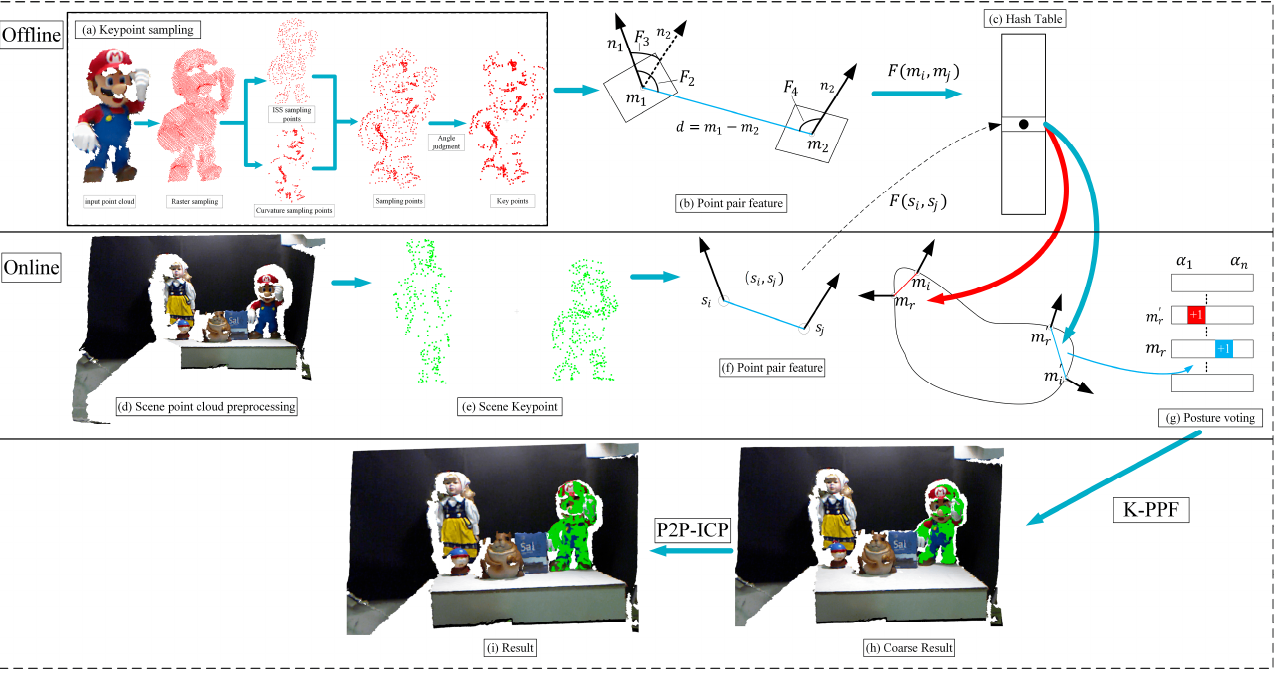
Figure 1. The algorithm flow of this paper; first, in the offline stage, the model training keypoint pair features are stored in the hash table ( a–c ). Then, the online stage preprocesses the scene point cloud ( d ), extracting keypoint pair features and performing the model point cloud hash table Quickly vote ( e , f ), clustering the point clouds with high votes ( g , h ); finally, point-to-plane ICP for further fine registration is performed, and the 6D pose after fine registration derived ( i ).